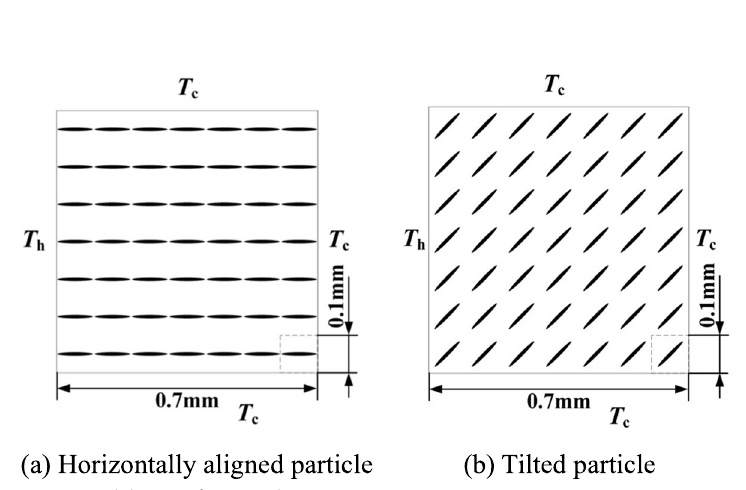
Fig. 9 Computational domains for Example